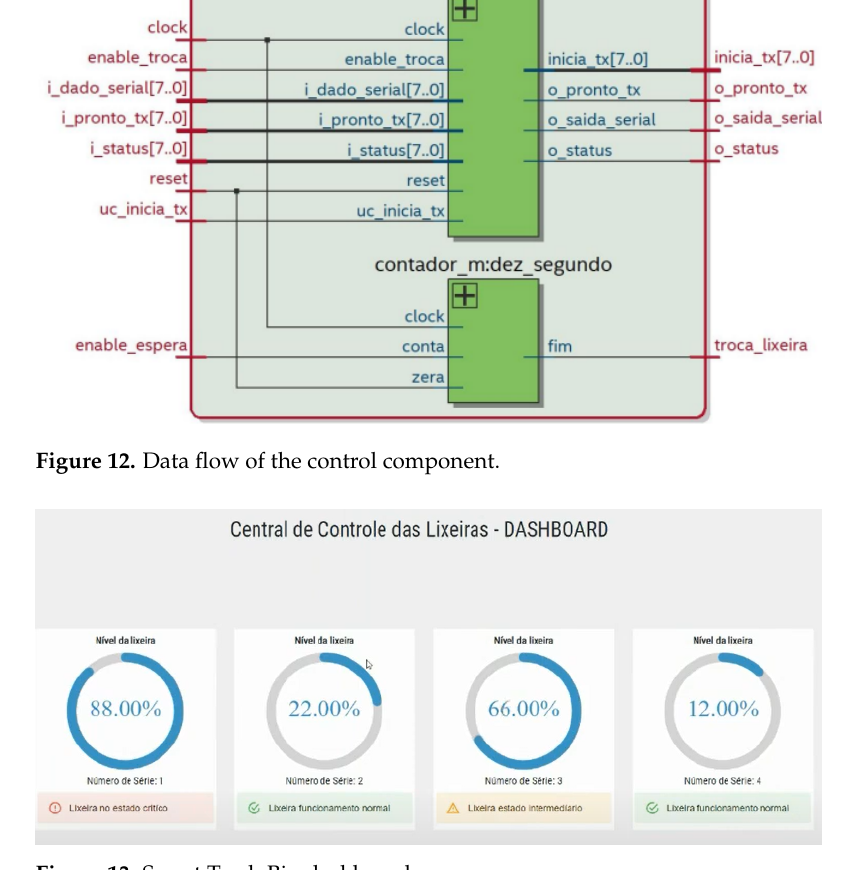
Figure 13. Smart Trash Bin